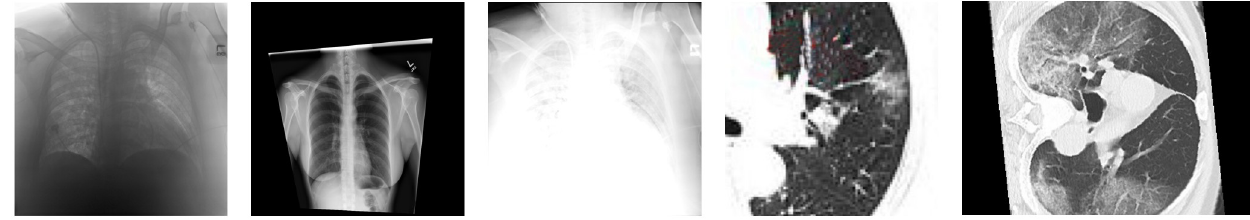
Figure 10. Some data augmentation techniques that work well for images of general objects are too aggressive for medical